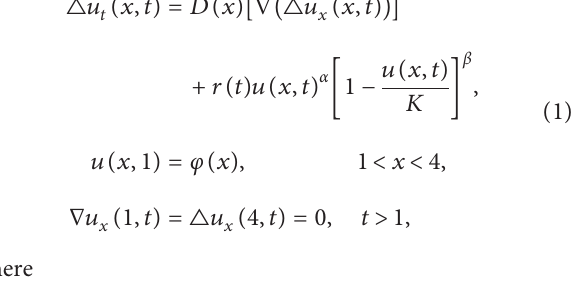
Global transport of PM 2.5 between clusters